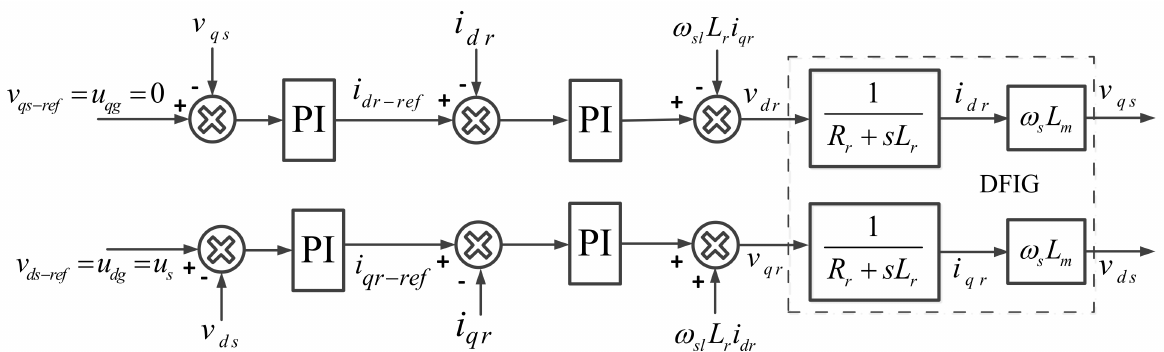
Figure A1. Control diagram of RSC with PI